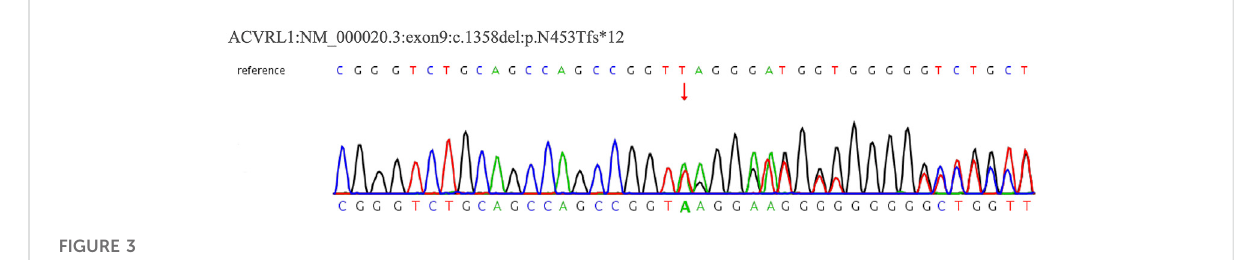
FIGURE 3 WES result for Case 1 ’ s patient. The sequencing of heterozygous mutation of the ACVRL1 gene c.1358del.